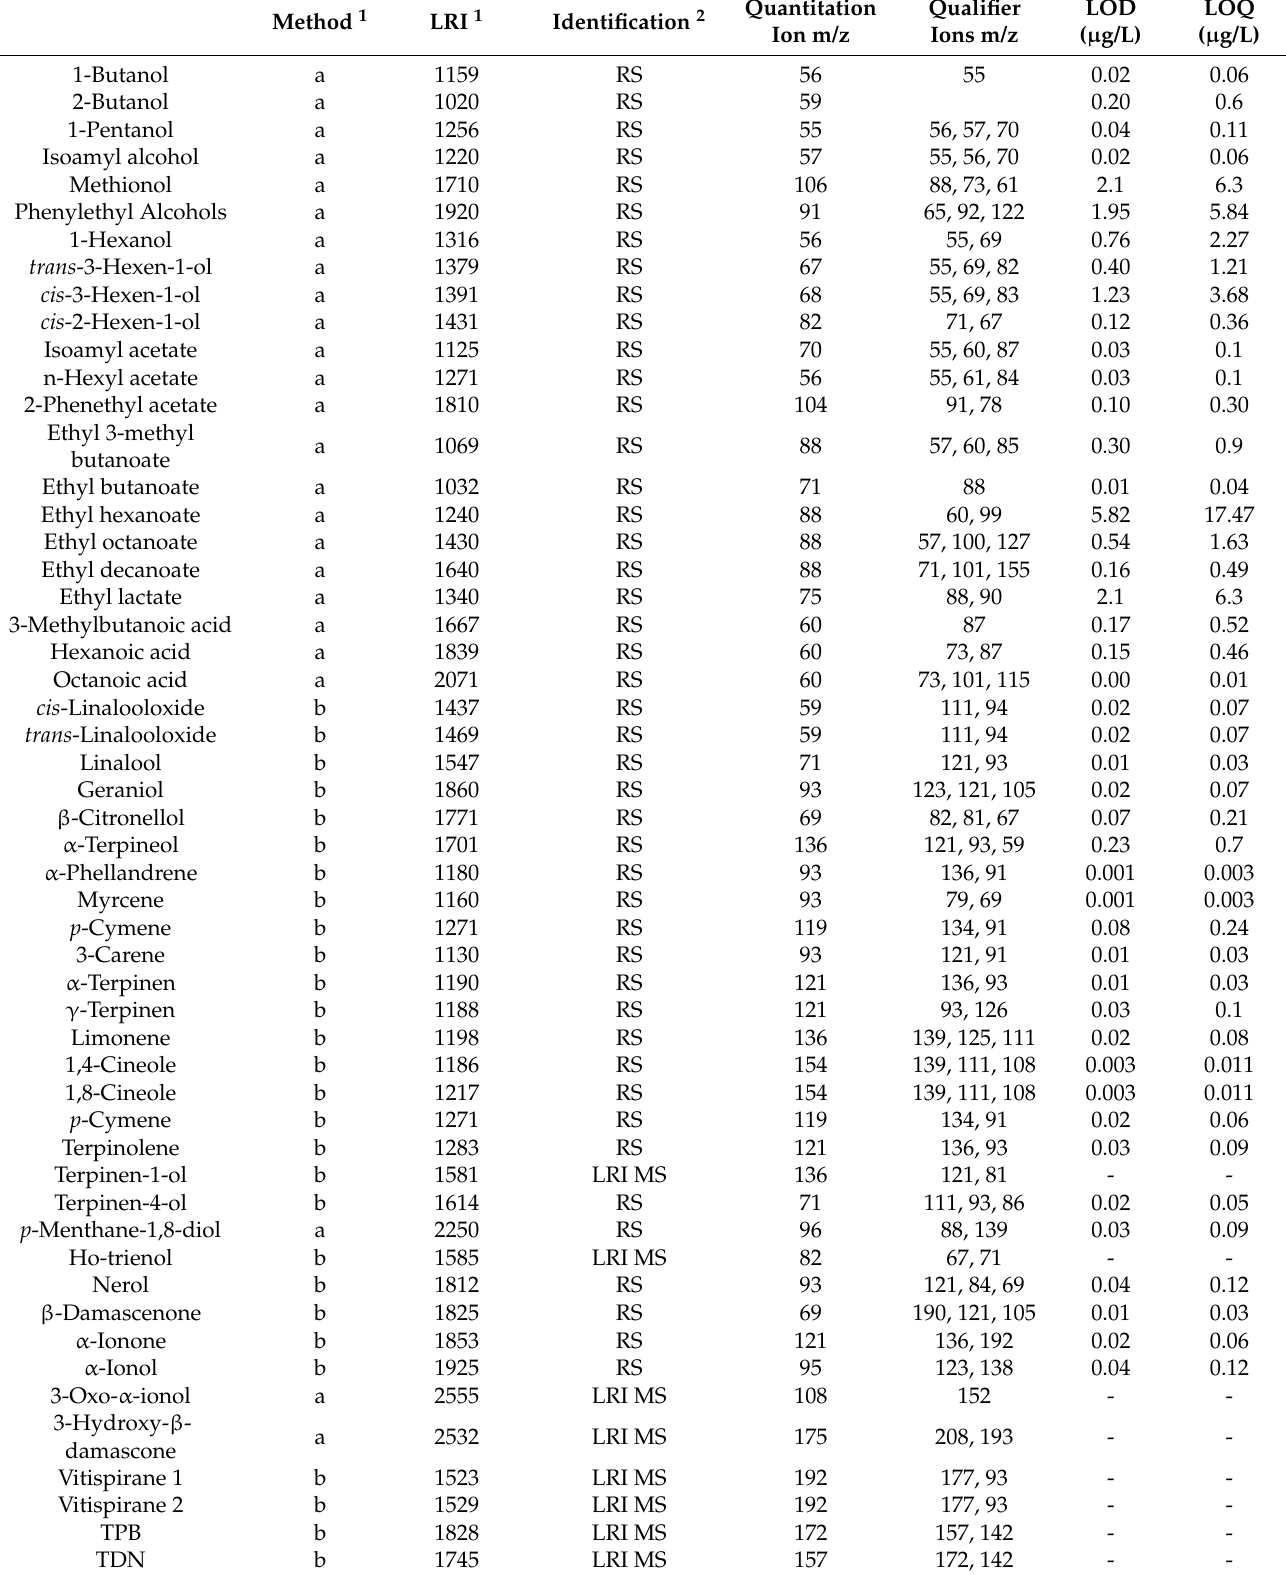
Table 7. Retention indices, quantification ions of studied